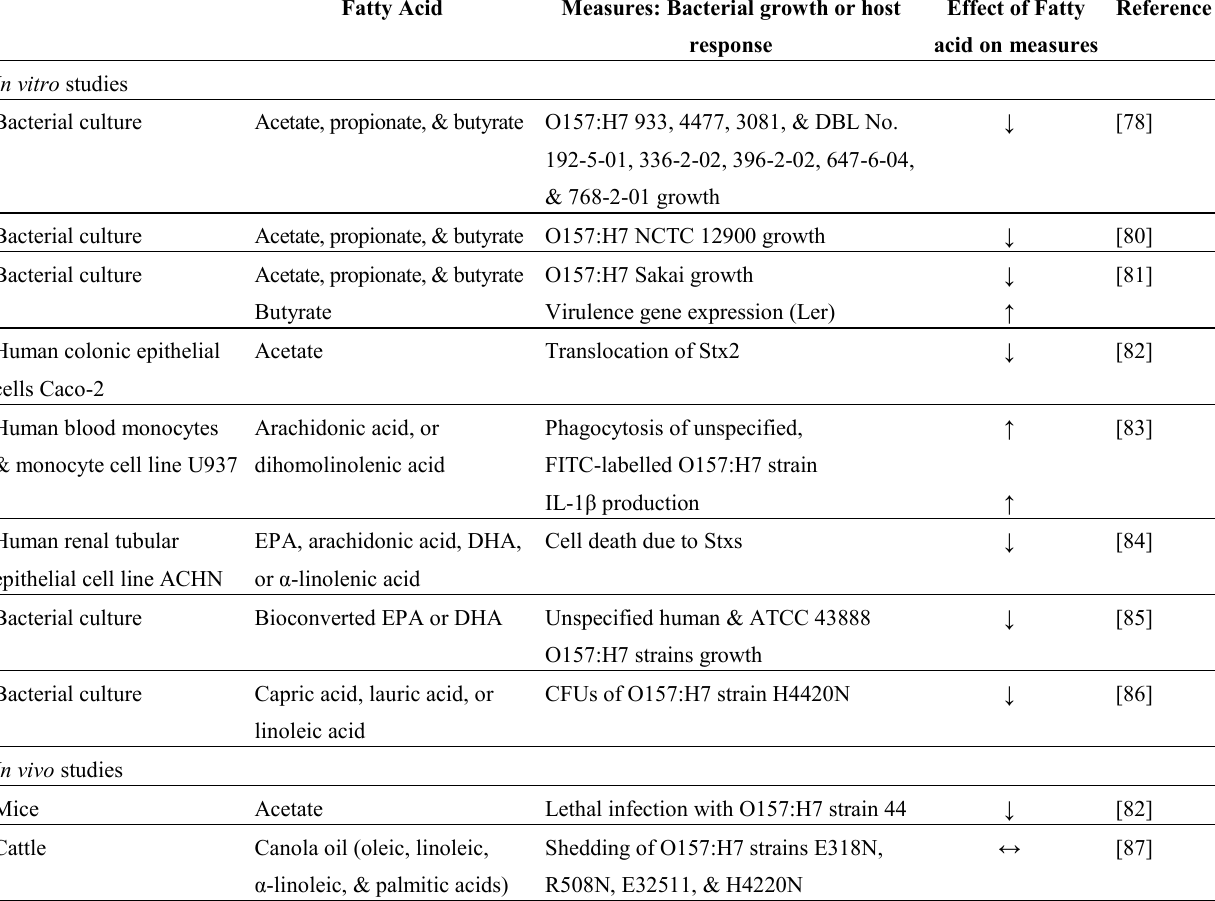
Table 3. Impact of dietary fatty acids on Shiga toxin-producing E. coli growth and pathogenesis. Fatty Acid Measures: Bacterial growth or host Effect of Fatty response acid on measures